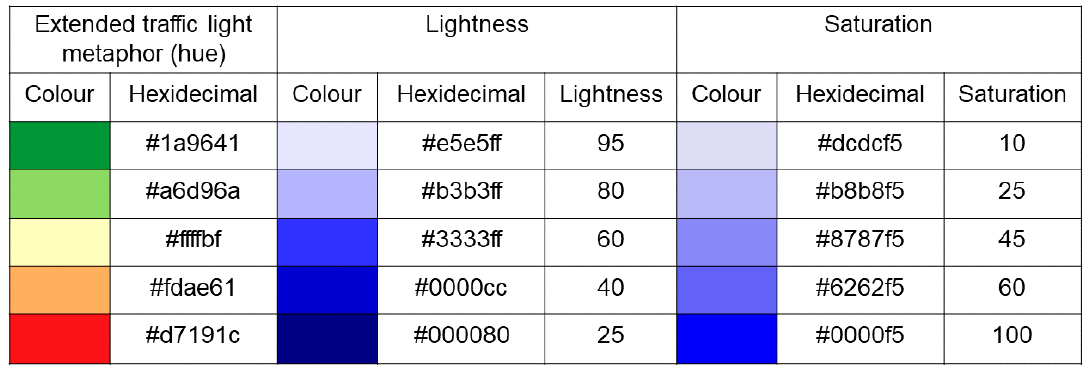
Table 1. Representation of the percentage of uncertainty values per field.